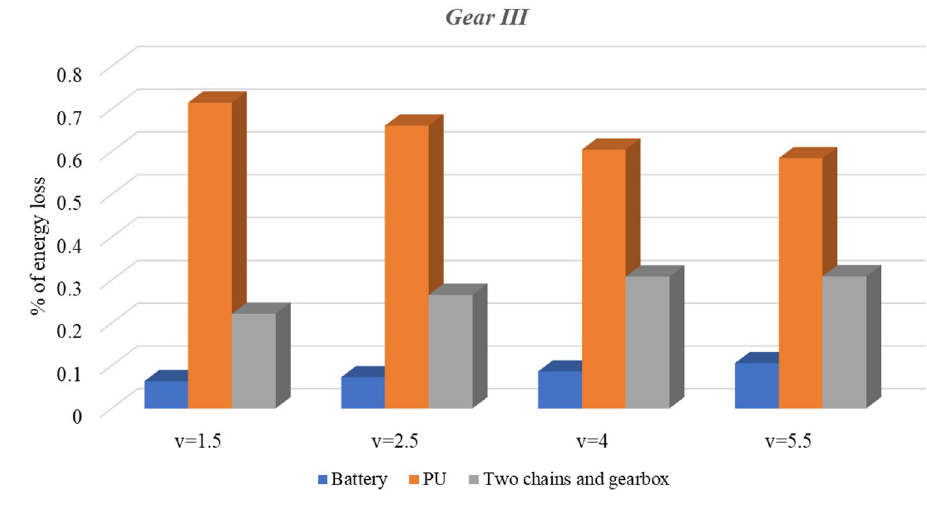
Fig. 18 Distribution of energy loss in the transmission com- ponents as a function of travel speed (m/s)